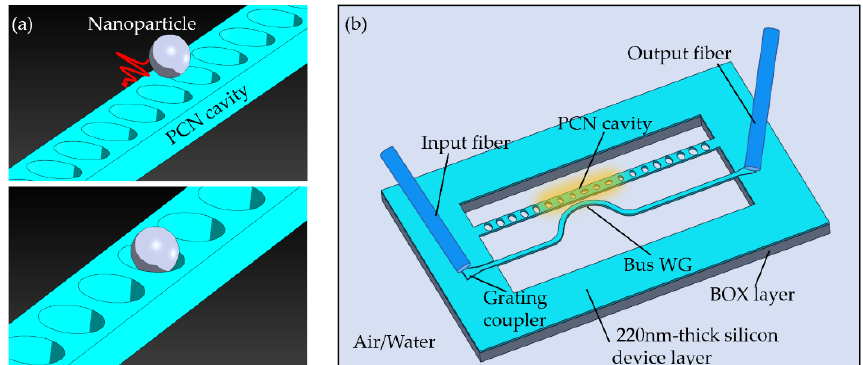
Figure 22. ( a ) Analytical model of PCN cavity for nanoparticle trapping [134–136] ; ( b ) optomechanical PhC cavity operation in water for mass sensing (the colored box indicates that the optomechanical device is immersed in water) [137] . Appl. Sci. 2020 , 10 , x FOR PEER REVIEW